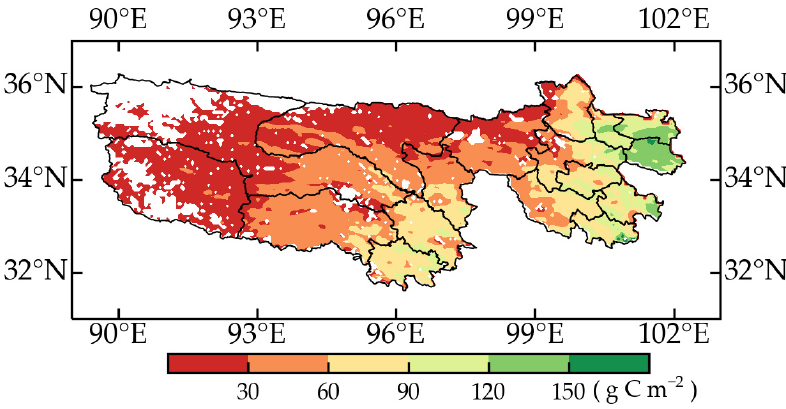
Figure 7. Spatial pattern of average AGB in the TRHR during 1982–2018.